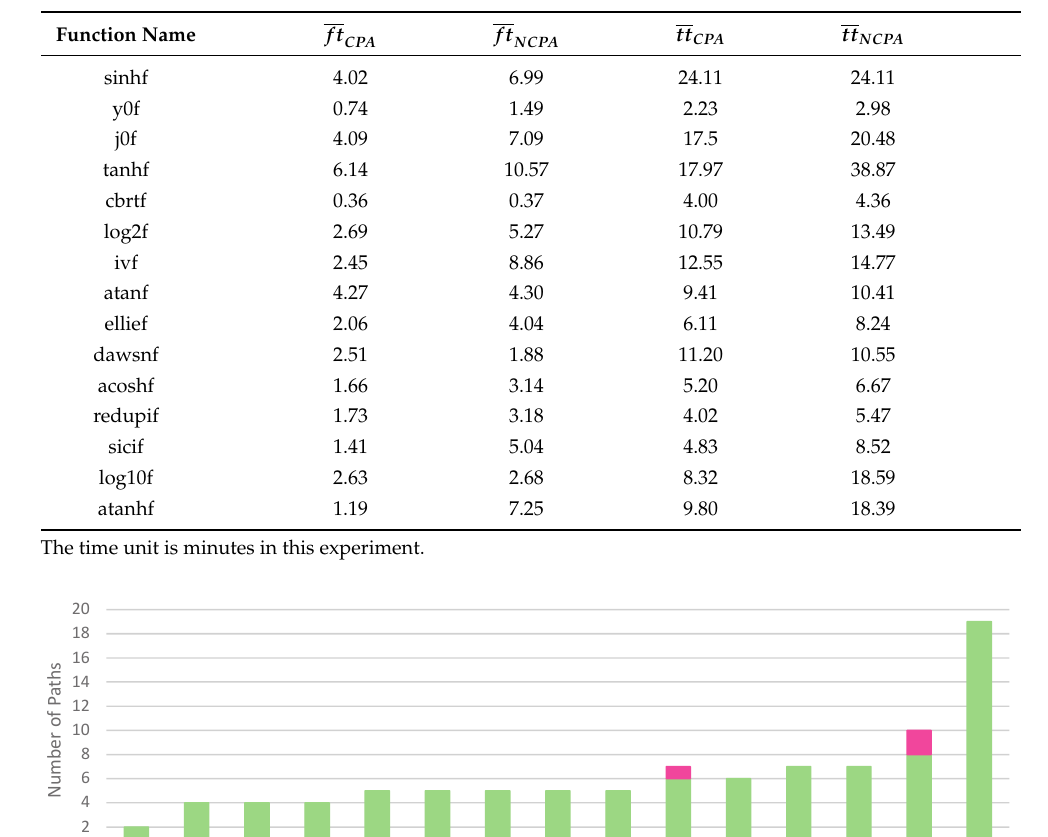
Table 3. ft and tt of Selected Functions.